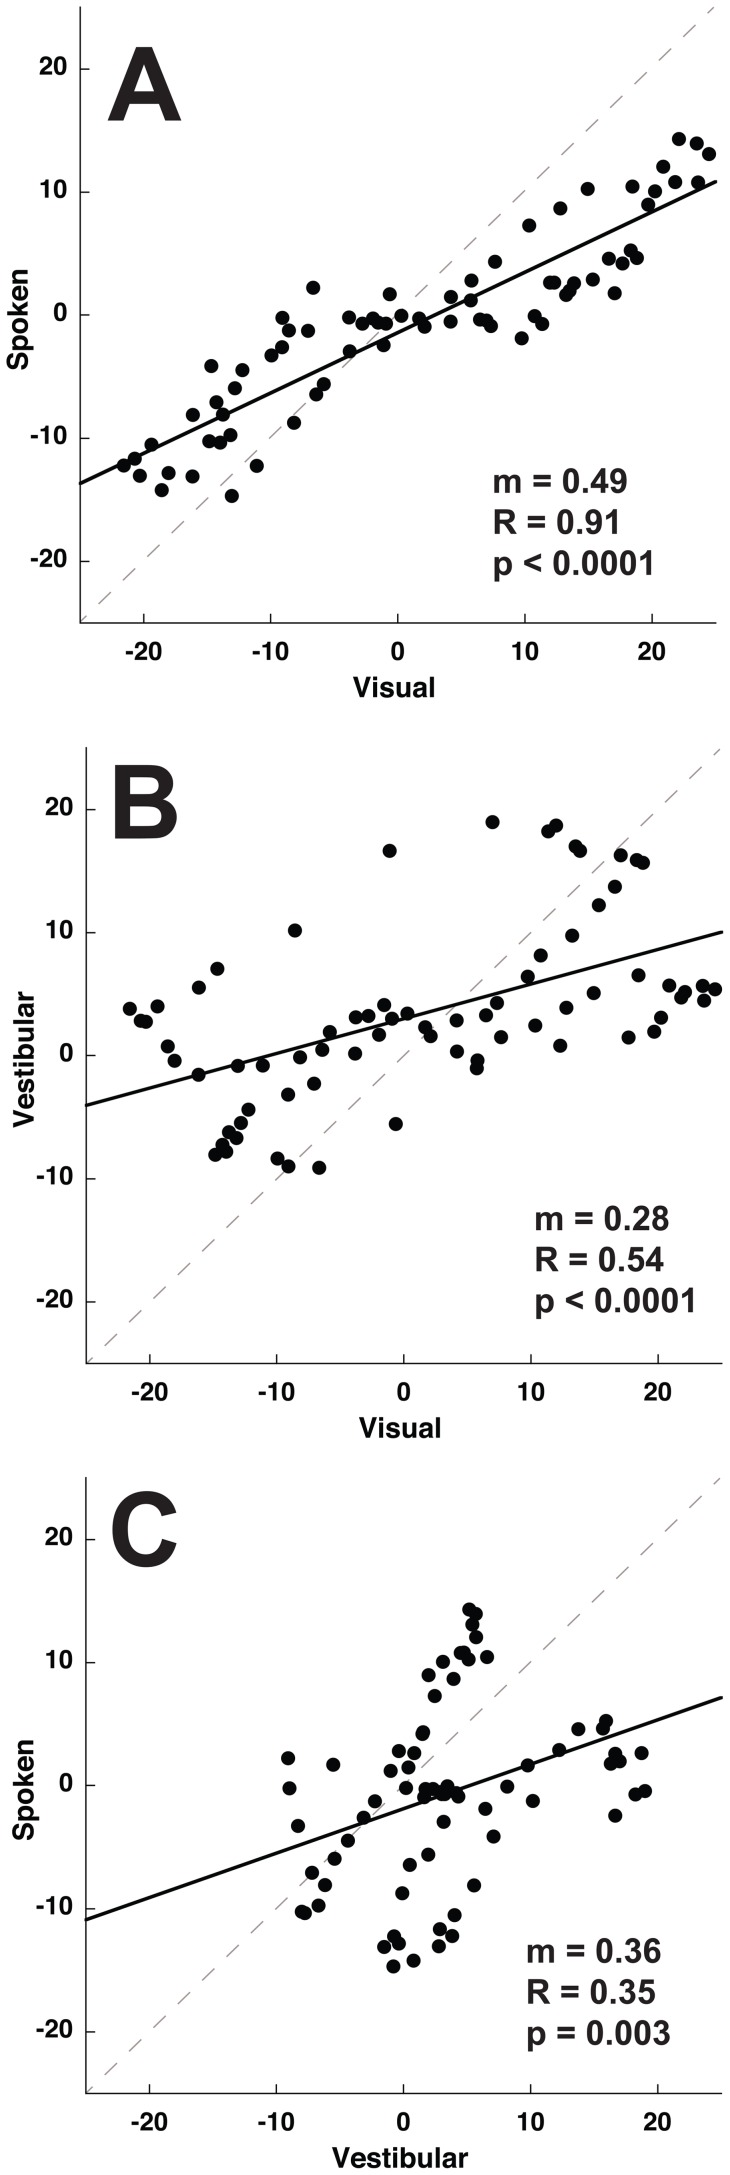
Correlations in direction specific bias between subjects for 3 stimulus conditions.Data was generated from responses combined across subjects. There is one data point for each of the 72 stimulus headings. The same error could occur at multiple headings so any given error in one sensory modality could correspond to multiple errors in another. Slope (m), Correlation coefficient (R), and p-value are given for each condition. A solid line represents the best-fit linear regression. The gray dashed line represents unity. Panel A: Visual-spoken. Panel B: Visual-vestibular. Panel C: Vestibular-spoken.